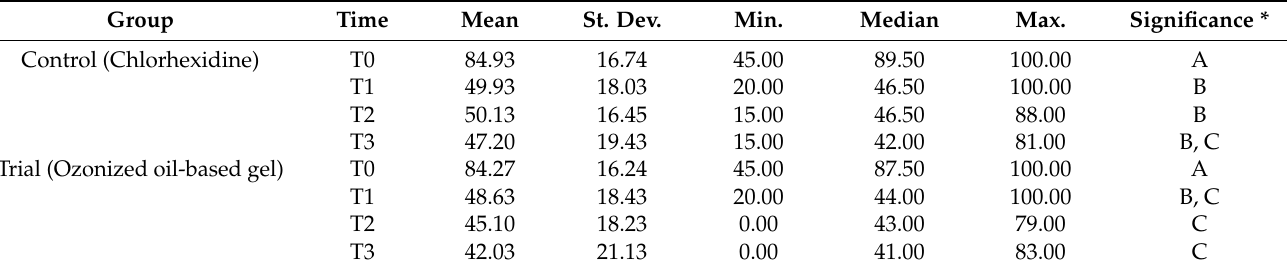
Table 5. Descriptive statistics of plaque index (PI).